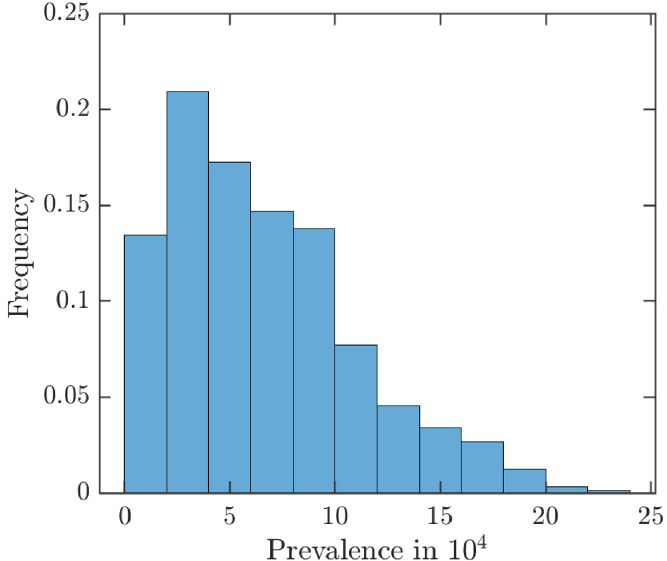
Fig 19. Uncertainty analysis for the MPX prevalence in 10 4 unvaccinated population (the average is approximately 6.5).